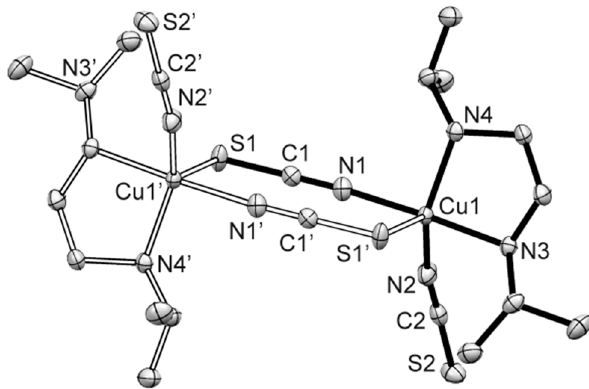
Figure 4. Perspective view of the dimeric compound 4 (60% probability ellipsoids). Symmetry code: (‘) 2 − x, − y, − z. Selected bond distances (Å) and angles (°): Cu(1)-N(1) 1.9487(13), Cu(1)-N(2)